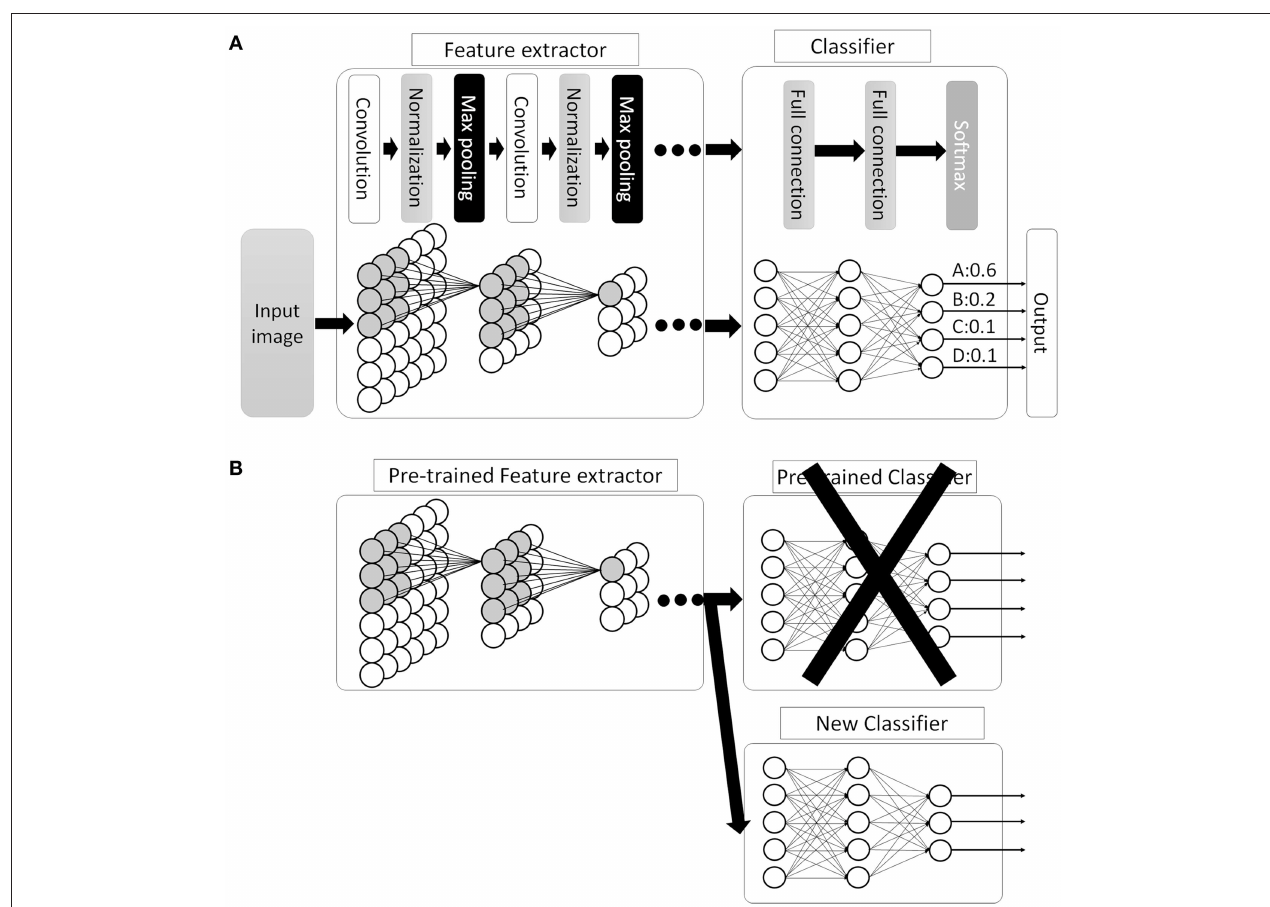
FIGURE 5 | Convolutional neural network (CNN). (A) Schematic image of CNN. Between the convolutional layers, each nodes connect to distinct nodes of the previous layer, which is different compared with ANN (as in Figure 4B , all the nodes between the layers are fully connected). By this feature, CNN can successfully capture the spatial and temporal dependencies in an image. Then, the fully connected classifier output the result as a probability distribution. (B) An example of transfer learning in CNN. In this example, replace classifier and use pre-trained CNN layers as feature extractor. Then, train the system to fit the new task.